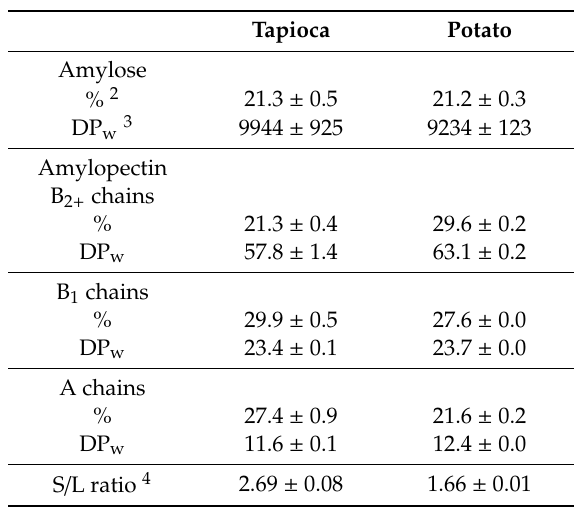
Table 1. Chain length distribution parameters of starch 1